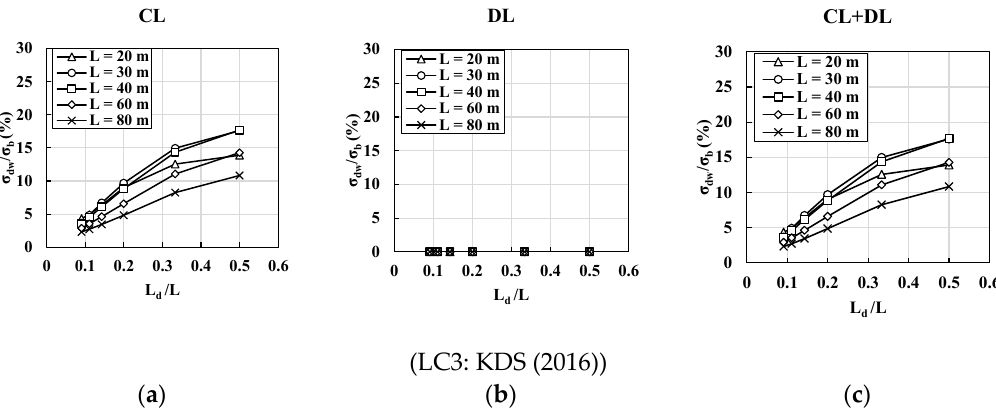
Figure 13. Variations in distortional warping normal stresses at H / B = 1.0 with the design load components. ( a ) Concentrated loads, ( b ) distributed loads, and ( c ) combined concentrated and distributed loads.